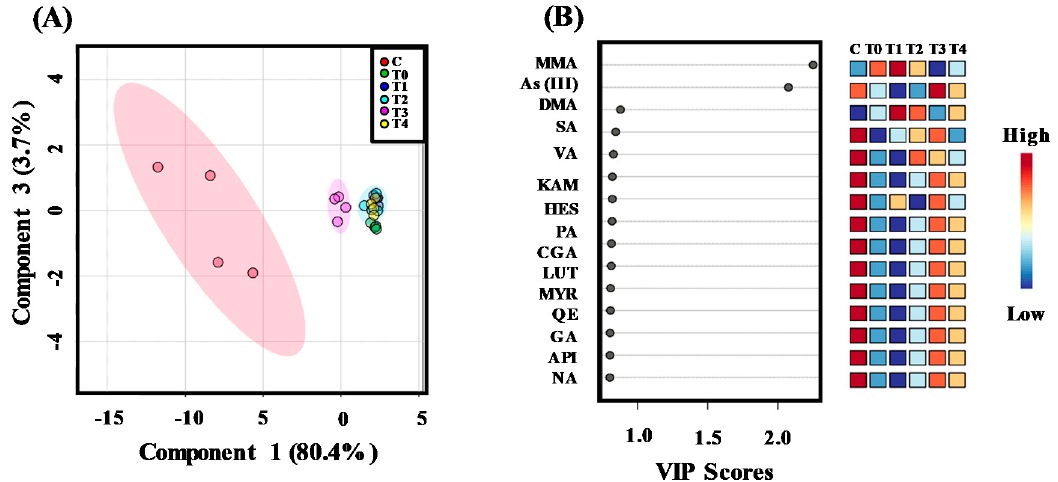
Figure 2. ( A ) Partial least squares discriminant analysis (PLS-DA) scores plot. ( B ) Variable importance in projection (VIP) scores plot indicating the most discriminating arsenic species, phenolics and flavonoids in of rice grain samples before and after exposure of different Arsenic (As) and combined As and phosphate (P) treatments. Treatments, C and T0, indicate untreated control, and 10 mg kg − 1 As treated group, respectively. T1, T2, T3, and T4 denote combined treatments, 10 mg kg − 1 As + 10 mg kg − 1 P, 10 mg kg − 1 As + 20 mg kg − 1 P, 10 mg kg − 1 As + 30 mg kg − 1 P, and 10 mg kg − 1 As + 40 mg kg − 1 P, respectively.